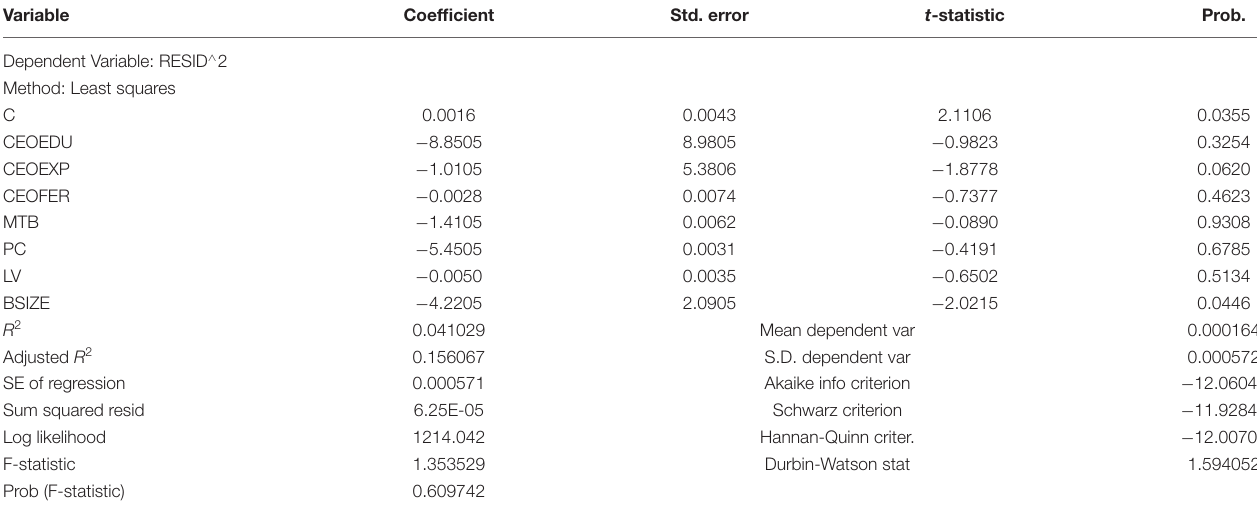
TABLE 5 | Breush-Pagan test.